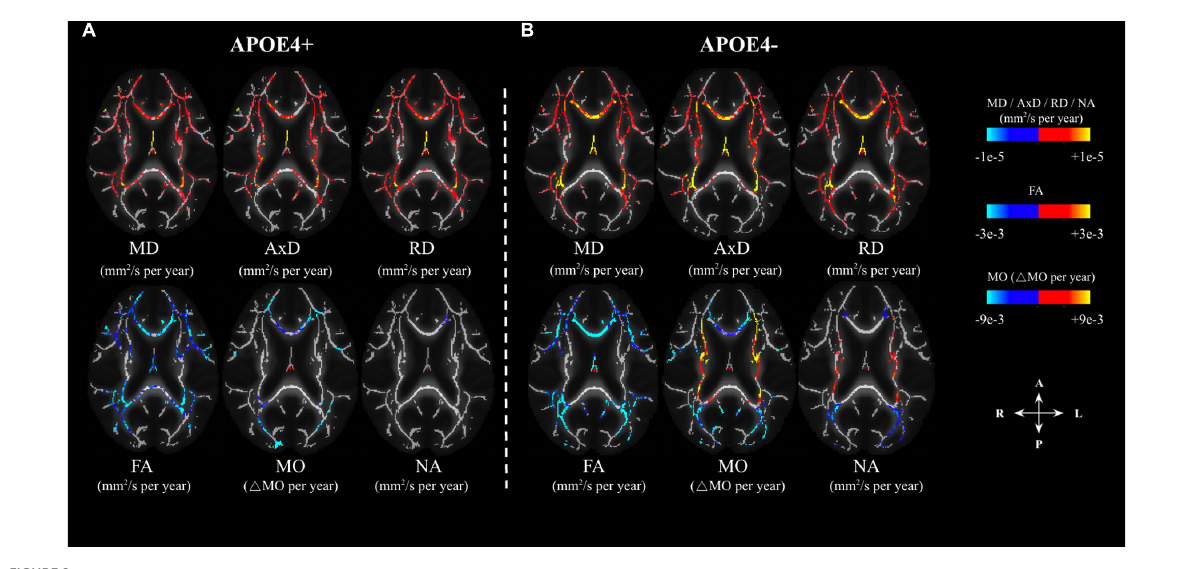
FIGURE2 Age-related differences in DTI metrics (FA, MD, AxD, RD) and DT-DOME metrics (MO, and NA) in APOE carriers (APOE4+) and non-carriers (APOE4–) ( A,B , respectively). The effects are shown in units of differences per year in the axial plane. The color bar shows negative (marked in blue-cyan) and positive (marked in red-yellow) change-per-year values, and only regions with statistically significant age associations (at p < 0.05) are shown. FA, fractional anisotropy; MD, mean diffusivity; AxD, axial diffusivity; RD, radial diffusivity; MO, mode of anisotropy; NA, norm of